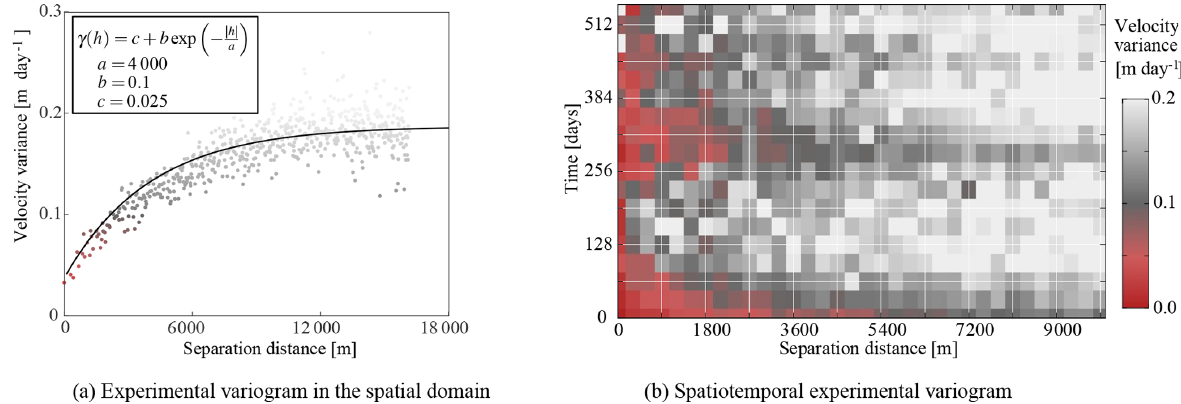
Figure 5. Experimental variograms over a slice of the stack and over a subset of the spatiotemporal stack. The color bar along the axis of (a) is used for the coloring of (b) . The aspect ratio of panel (b) is at the resolution of the produced data cube (32 days by 300m). In order to make this isotropic, the vertical axis needs to enlarge, so the spread in variance is similar in any direction